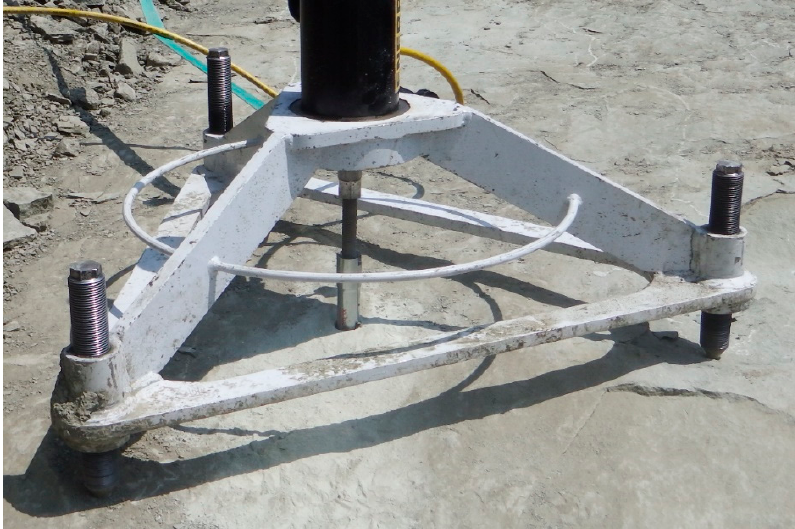
Figure 12. Device for pulling anchors.